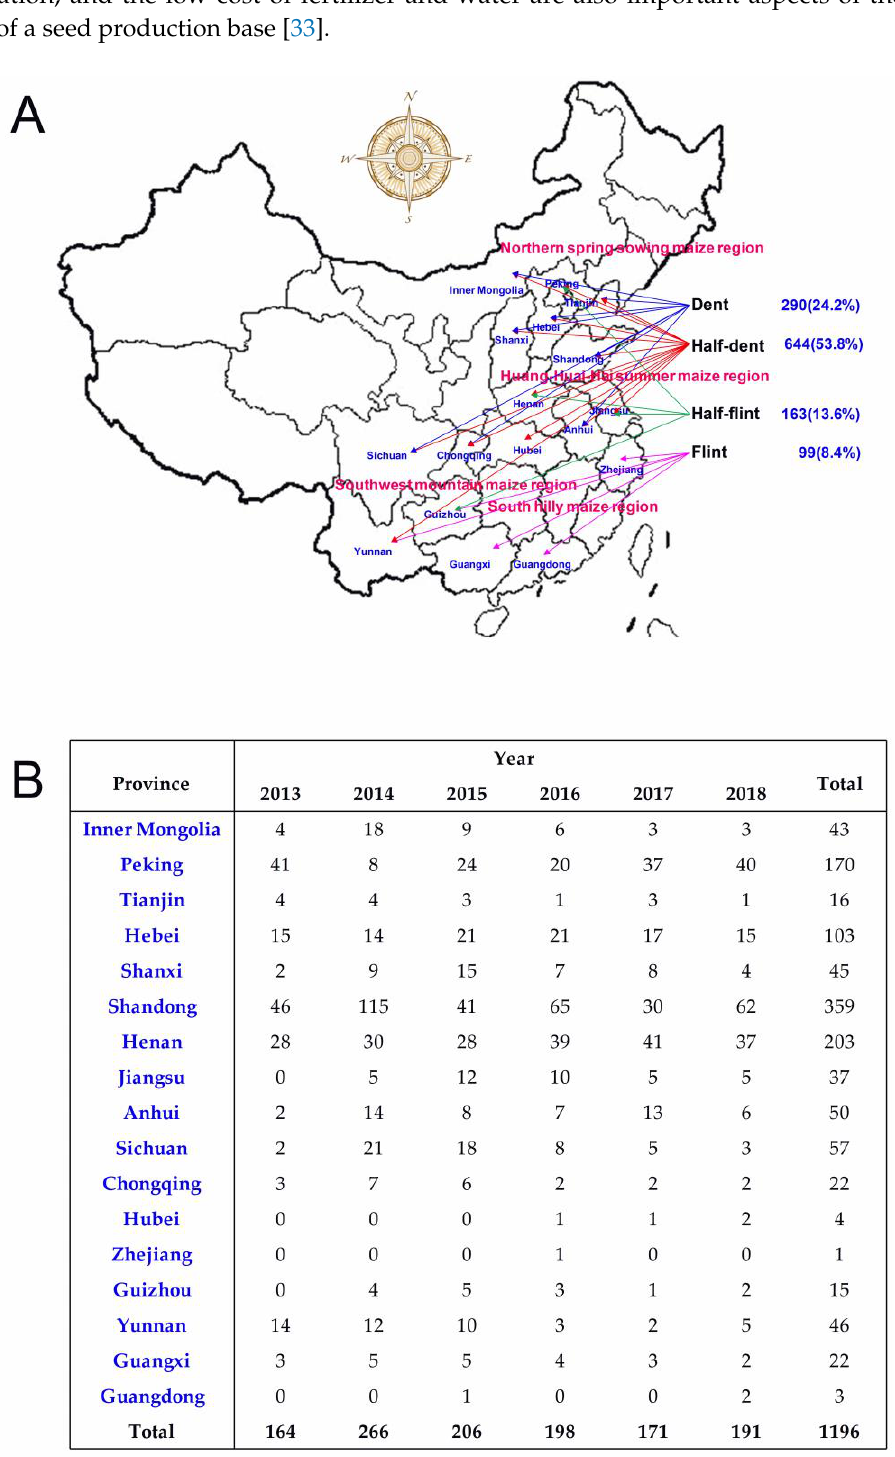
Figure 1. Overview of sample collection. ( A ) The main distribution of samples with four types in di ff erent provinces of north, Huanghuai, northwest, southwest, and south China (NHNSS). ( B ) The sample number collected from the provinces of NHNSS from 2013 to 2018.